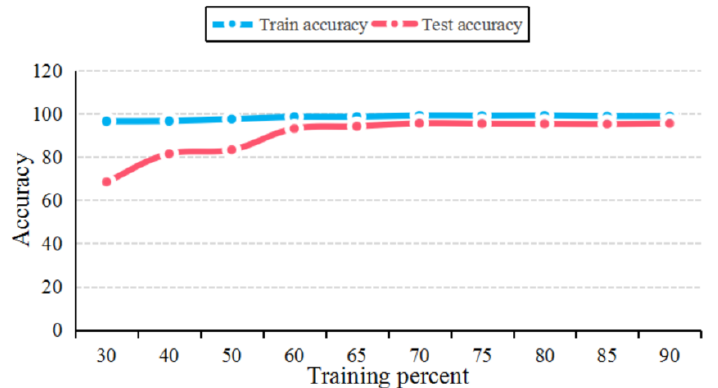
Figure 6. Recognition accuracy rates for different training percents.